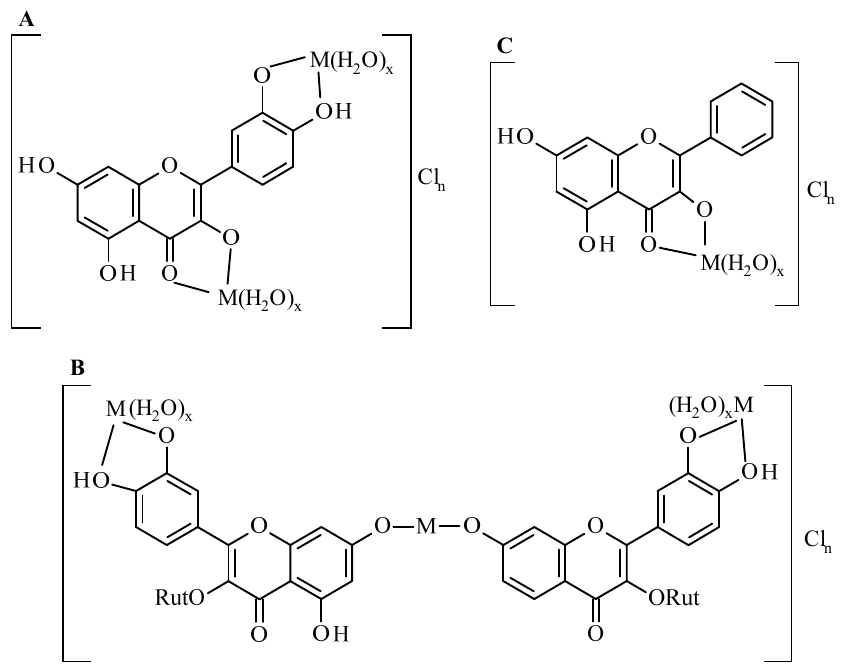
Figure 4. Structures of compounds 26 – 34 .